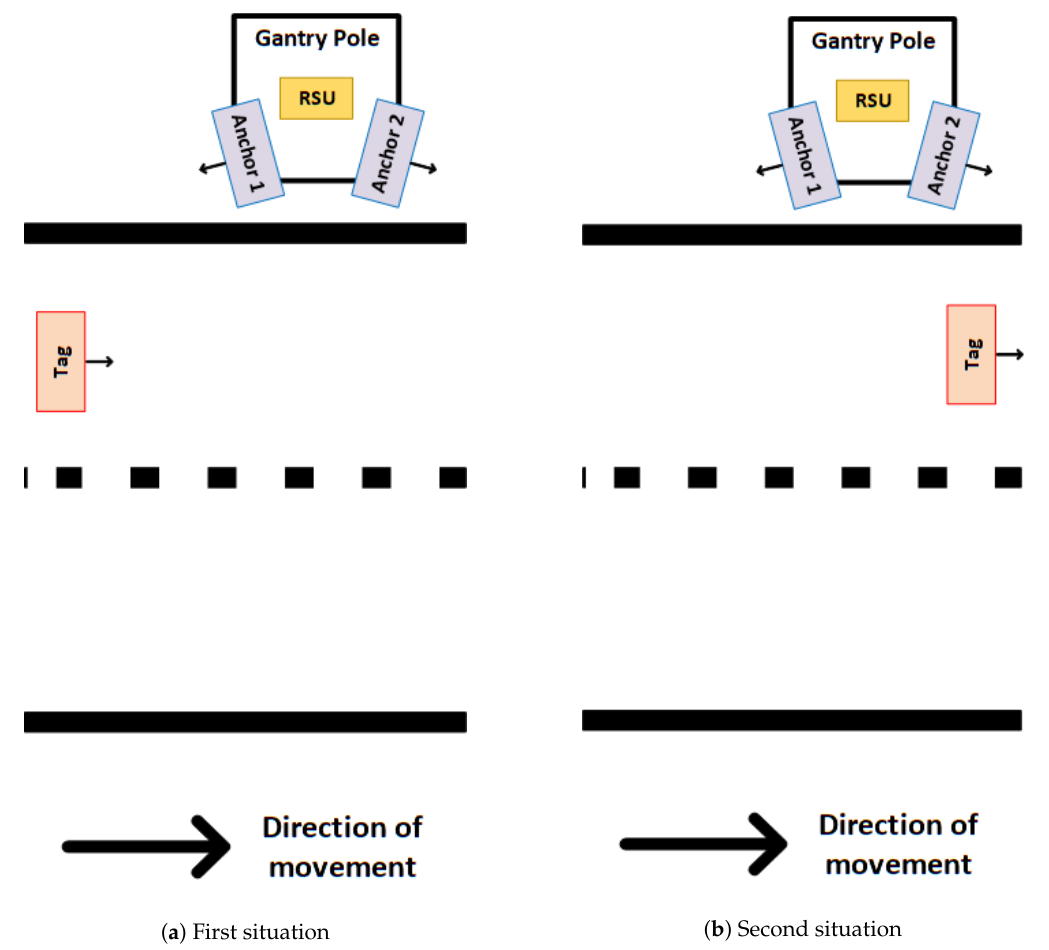
Figure 5. Possible situations regarding the relative orientation of the UWB anchors and tag